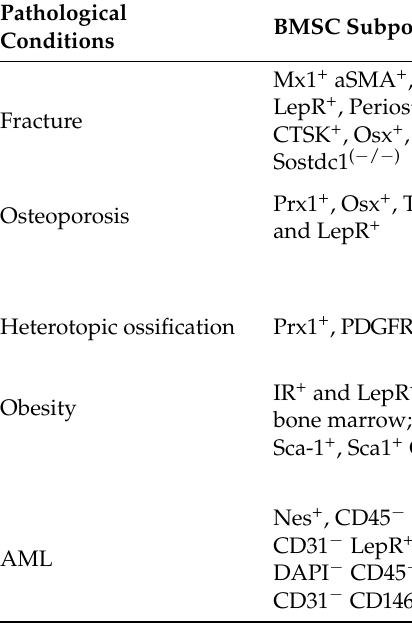
Table 2. Functional heterogeneity of BMSC subpopulations in